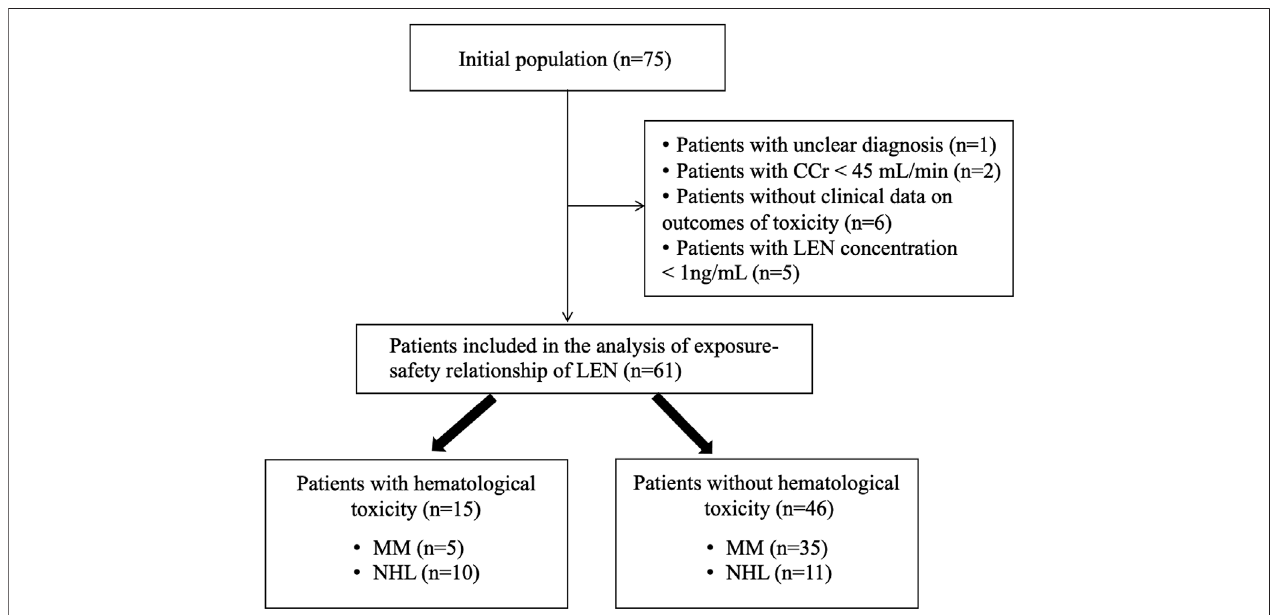
FIGURE 1 | Flow chart of the